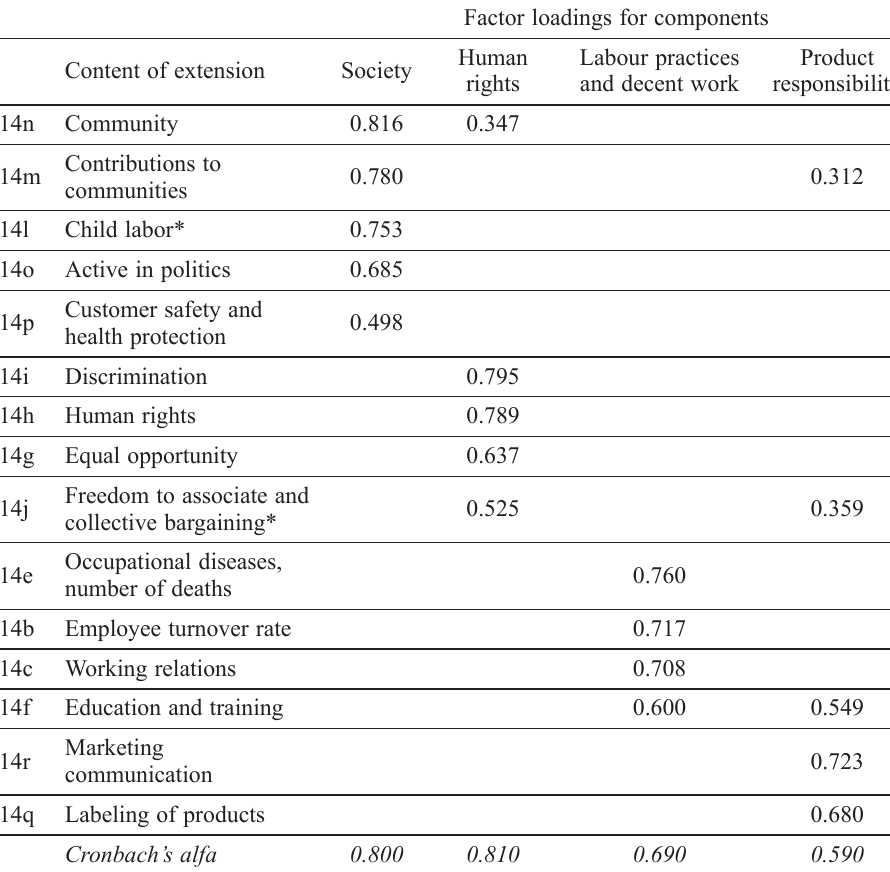
Table 4. Rotated component matrix for the extension contents Factor loadings for components